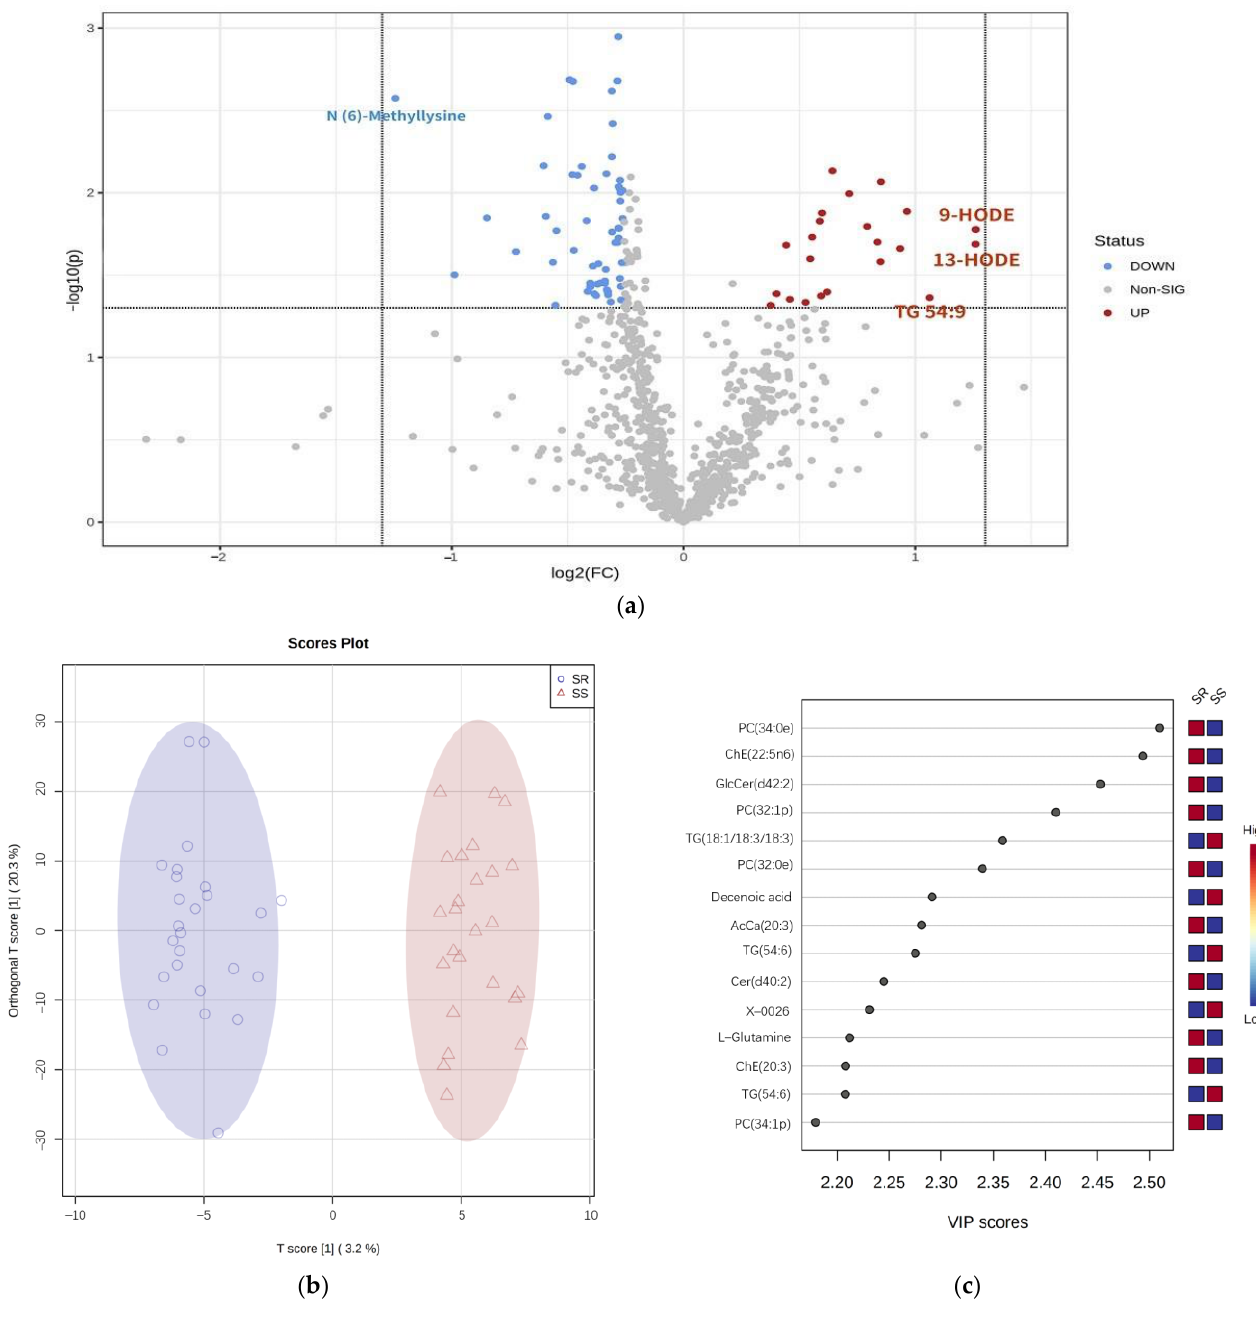
Figure 2. Metabolite signatures differentiate SS and from SR. ( a ): Volcano plot of differentially expressed metabolites. ( b ): OPLS−DA clustering the SS and SR. ( c ): PC 34:0e and ChE 22:5n6 are the most relevant parameters distinguishing SS from SR based on VIP score.